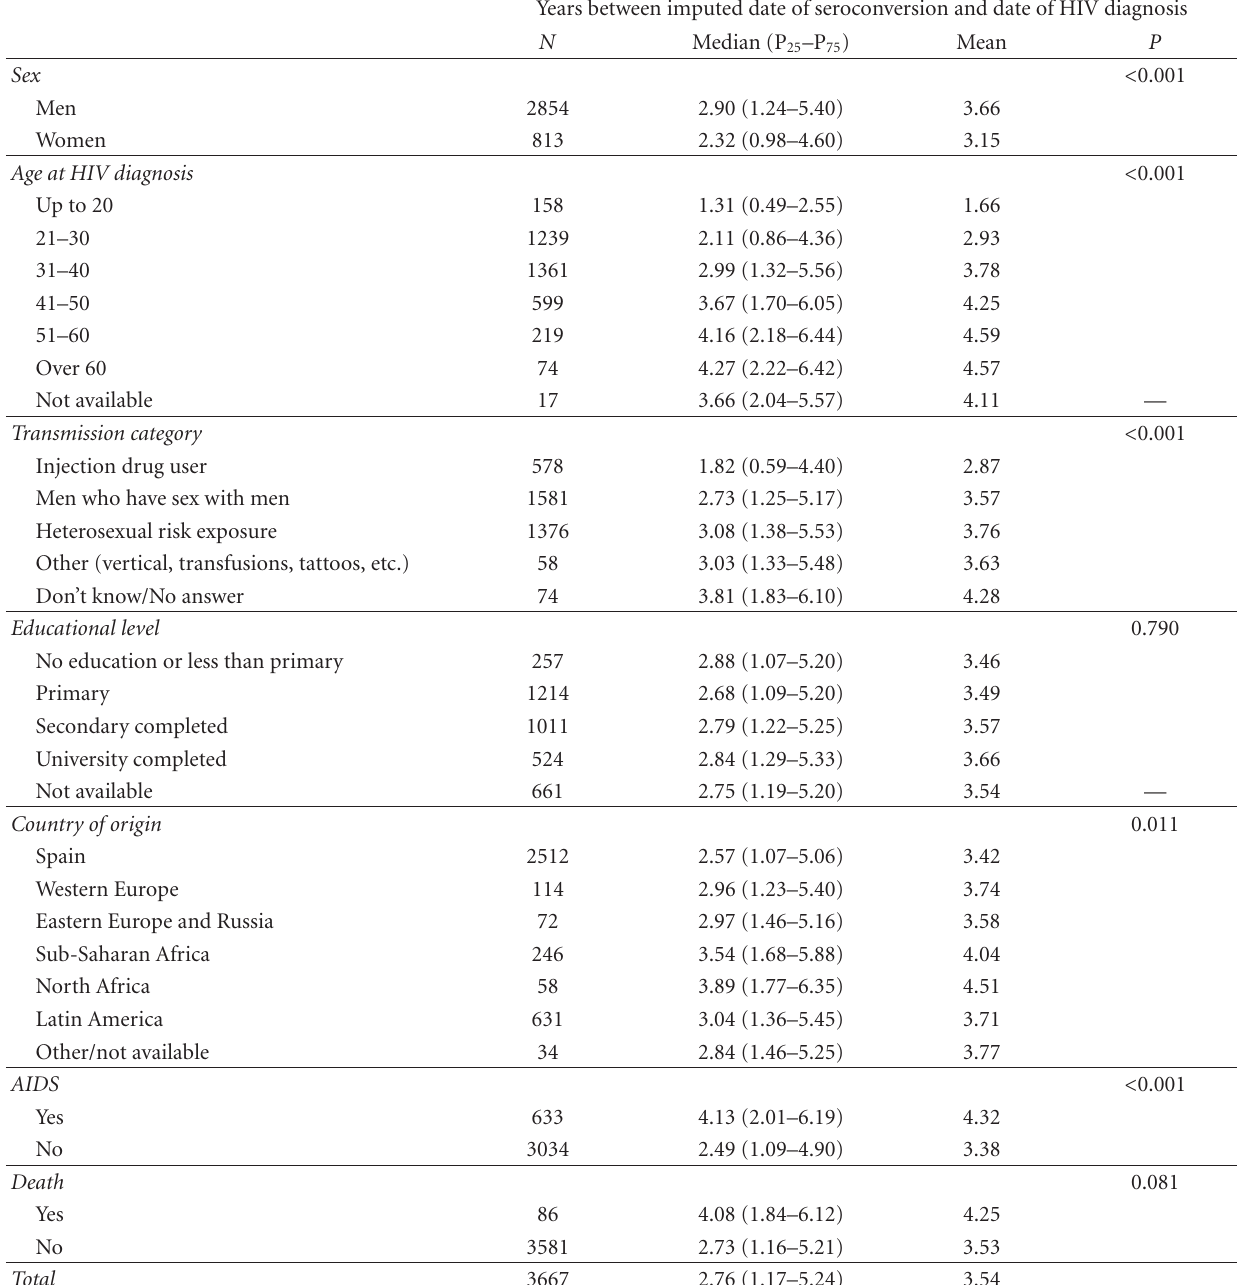
Table 1: Years between imputed date of seroconversion and date of HIV diagnosis in the whole cohort ( n = 3667). Years between imputed date of seroconversion and date of HIV